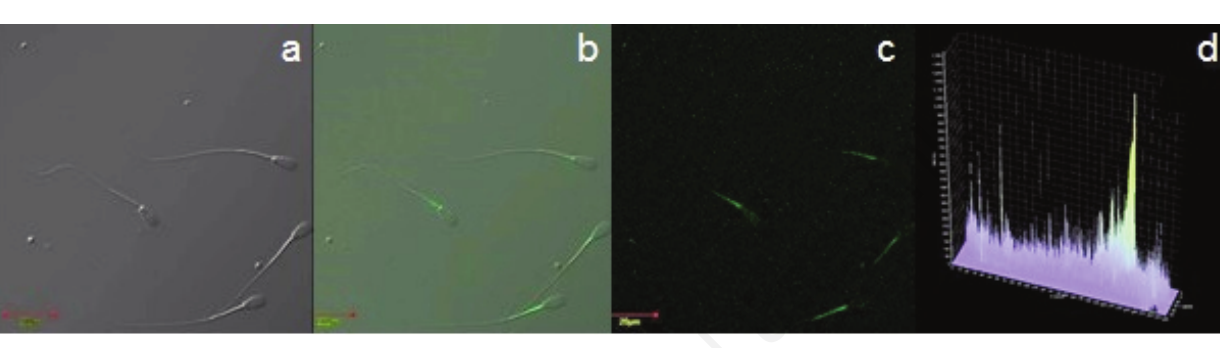
Figure 4. Ca 2+ Intensity with Fluo-3 Staining 400XZ 2.5 Treatment P3 Group (with supplementation of inference contrast; b) Super Infuse; c) Fluorescence; d) Ca 2+